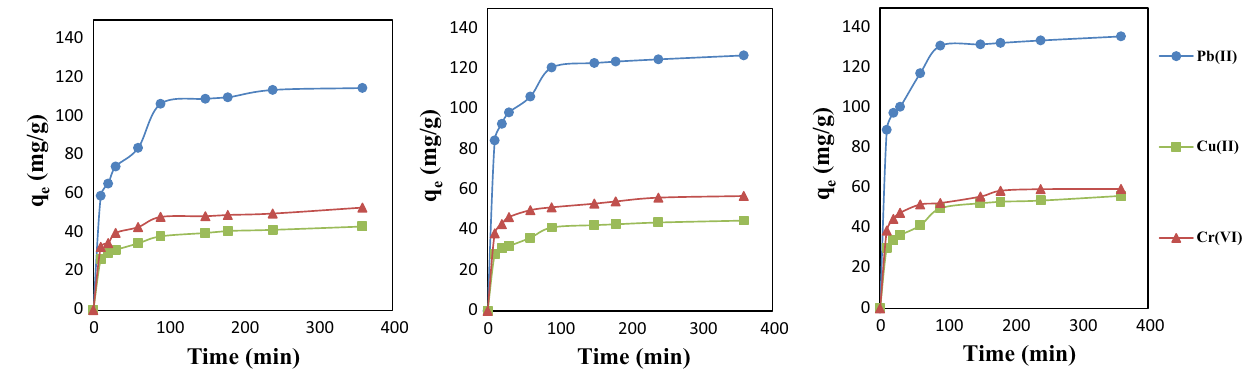
Fig. 9 Cu (II), Cr(VI), and Pb(II) uptake at different, contact time and temperature (initial metal ion concentration = 400 mg/L)